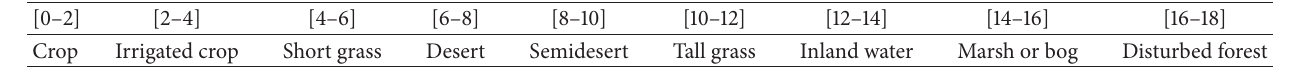
Figure 2: Distribution of land cover types used in this study: (a) the standard version of RegCM4 model and (b) the reforested one RegCM4 REFORESTATION. The red rectangle indicates the reforested zone. Table 1: Land cover types used in this study.